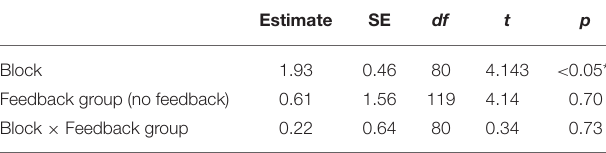
TABLE 8 | LME analysis on points earned in the training phase of Experiment